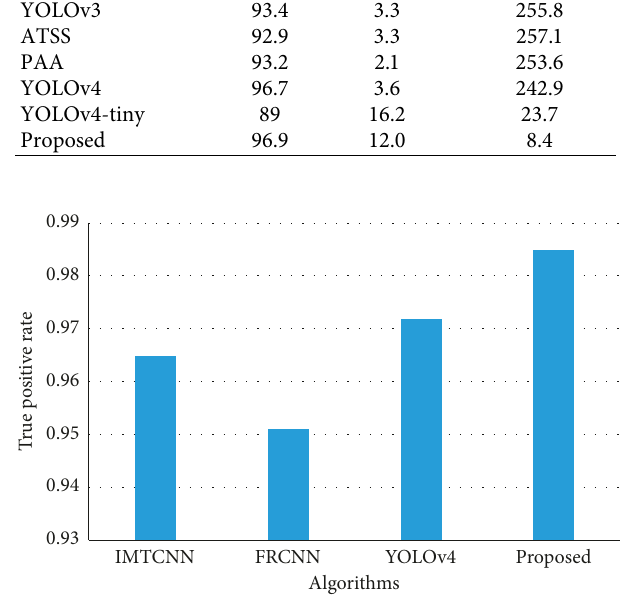
Figure 8: Performance comparison on FDDB dataset.